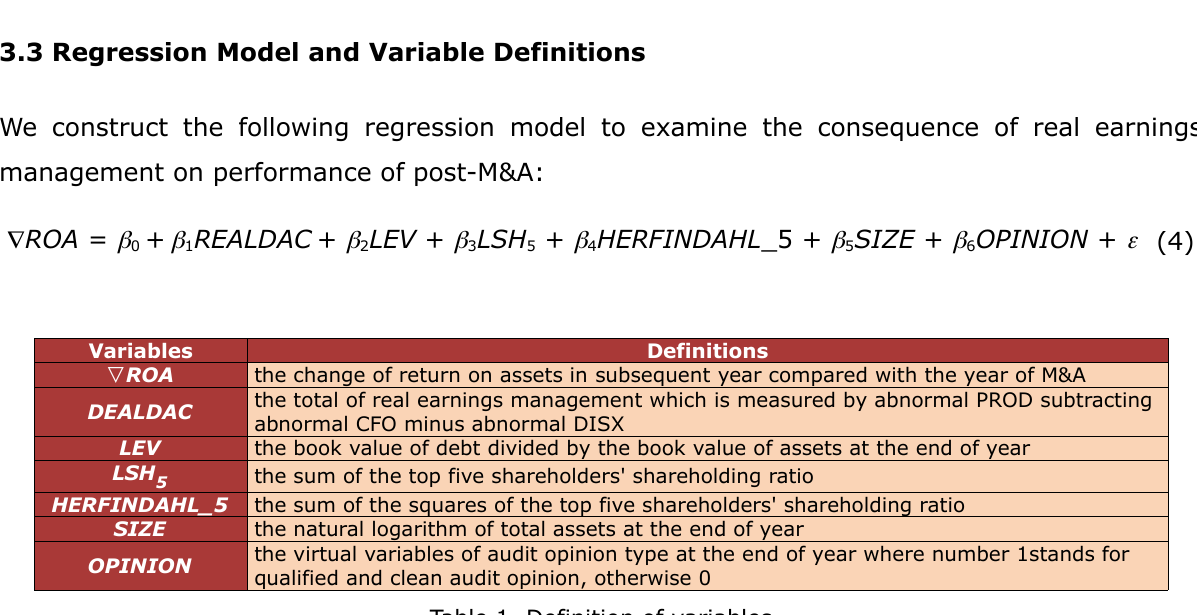
Table 1. Definition of